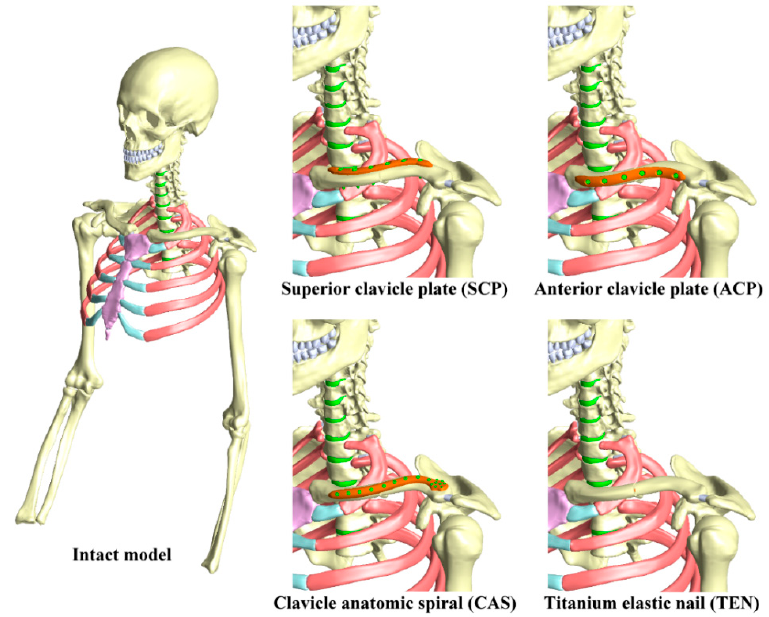
Figure 2. Complete human upper ‐ body models.